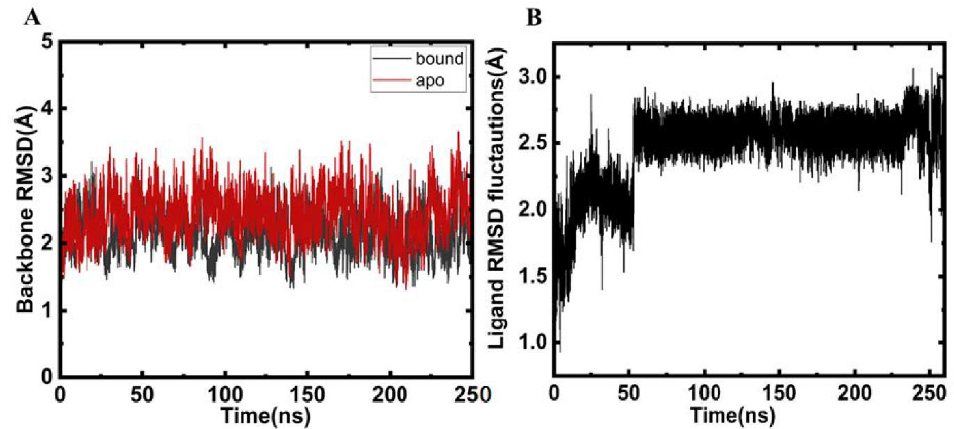
Figure 3. ( A ) RMSD plots of backbone atoms during the 250 ns MD runs. ( B ) RMSD plot of ligand during the 250 ns run.